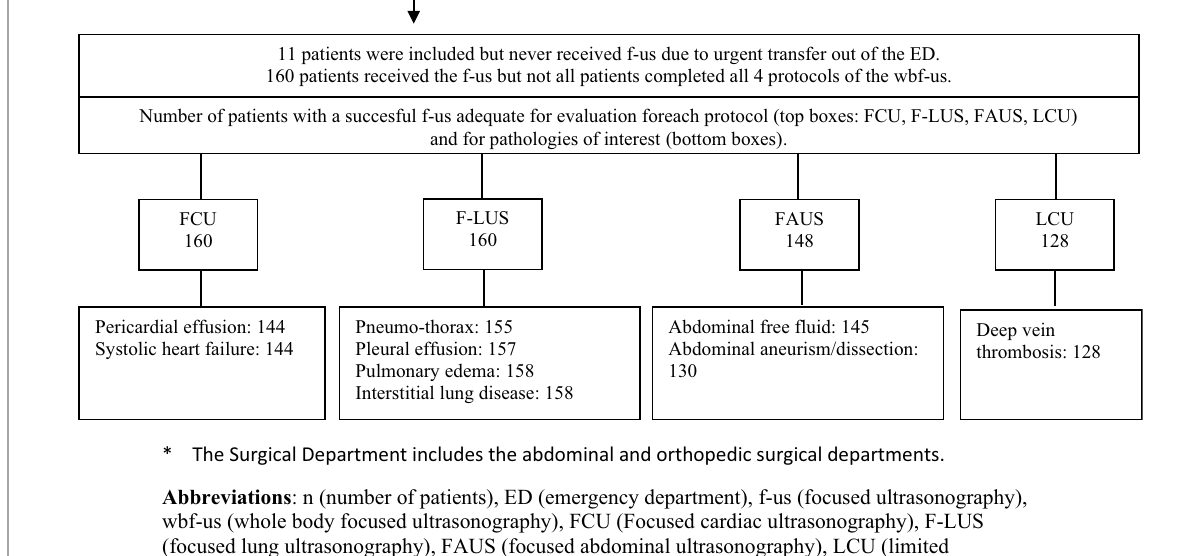
Fig. 1 Flow chart of inclusion of adult high acuity patients admitted to the Emergency